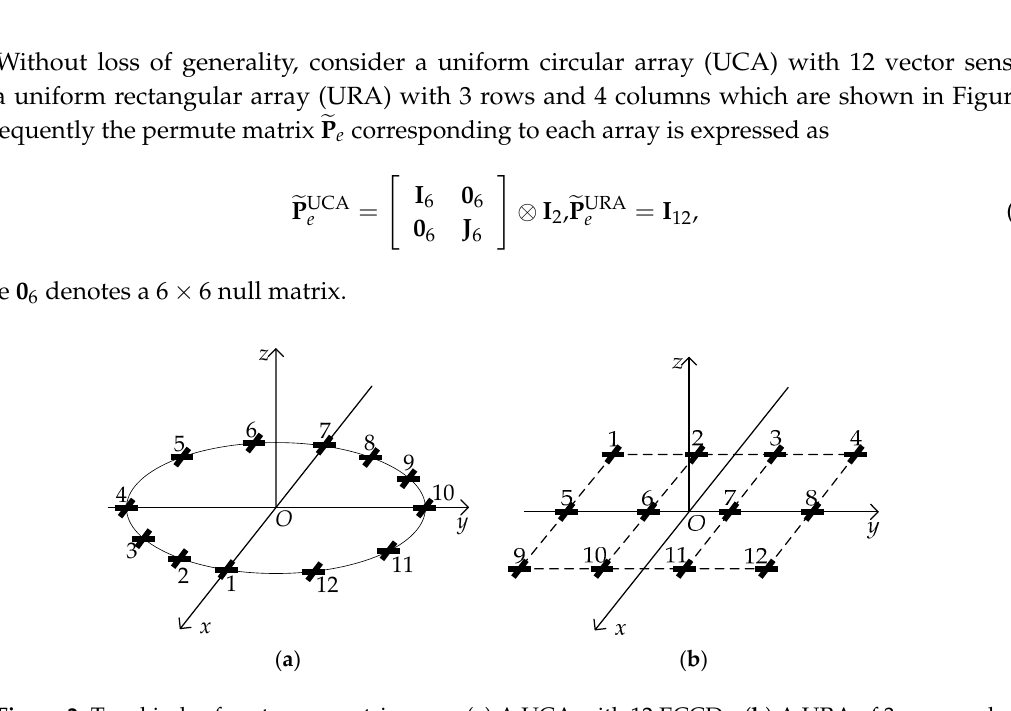
Figure 2. Two kinds of centrosymmetric array. ( a ) A UCA with 12 ECCDs; ( b ) A URA of 3 rows and 4 columns with totally 12 ECCDs. The numbers represent the order of vector sensors.